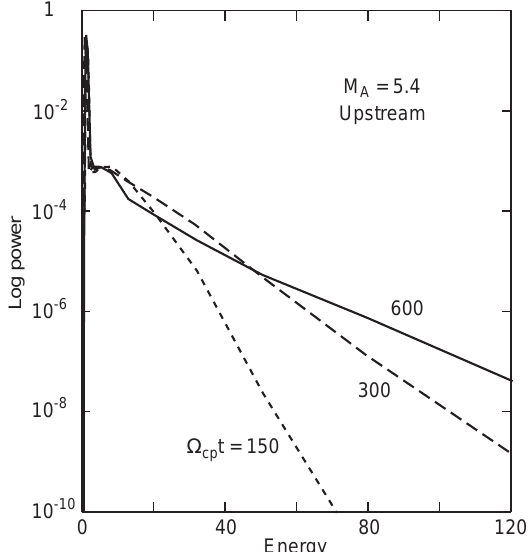
Fig. 4. Temporal development of the flux distribution at X cp t (cid:136) 600 upstream of a M A (cid:136) 5 : 4 shock with (cid:15) (cid:136) 0